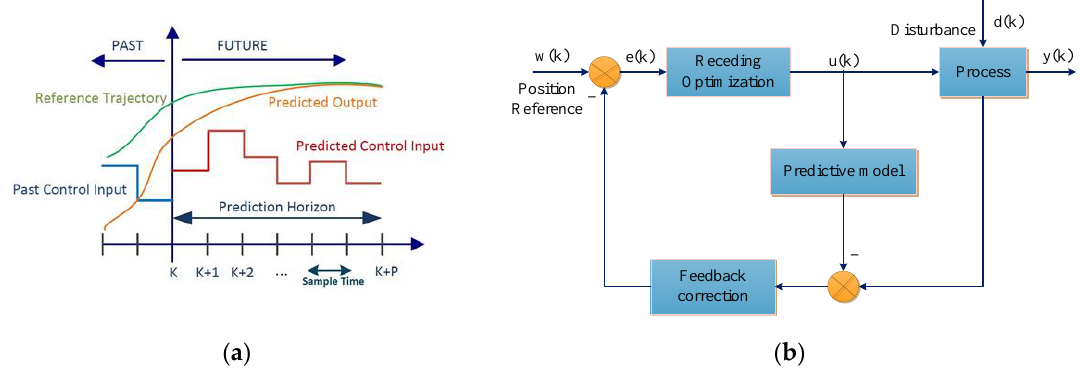
Figure 5. ( a ) The MPC system schematic control prediction horizon and ( b ) the general characteristic of the main block diagram of MPC.